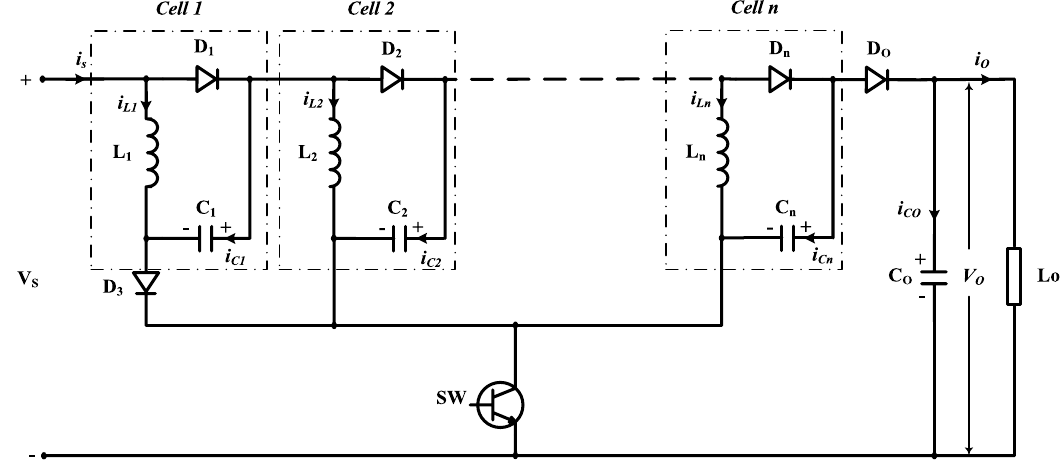
Figure 1. The multi-cells proposed DC-DC boost converter.